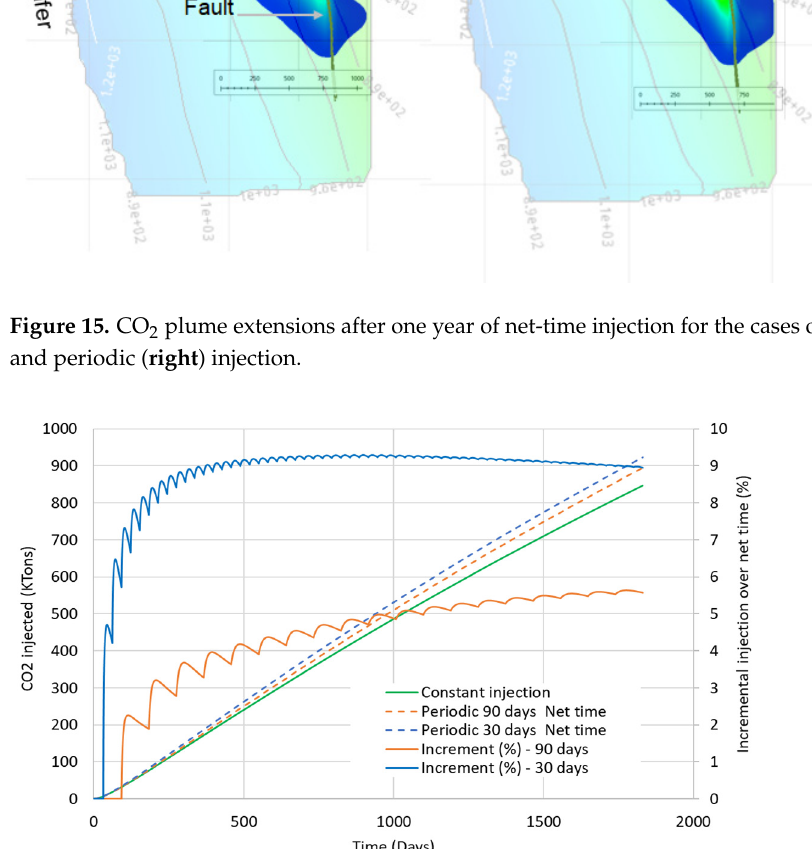
Figure 17. Net time rates of periodic injection vs. continuous injection rates for up-flank injection— clearly indicating rate improvements after each shut-in period. Mid-reservoir injection . Figures 18 and 19 exhibit the equivalent results, indicating lesser rate benefits of periodic injection in this case, particularly for the three-month half- cycles. The reason seems to be the gravitational effects, stimulated by the formation dip and thicker reservoir zones. While the up-flank injection rapidly establishes a stable CO 2 cap around the injector, the mid-reservoir injection allows for CO 2 to migrate vertically within each layer as well as up-dip during shut-ins due to density differences, leaving water to re-occupy the well surroundings.